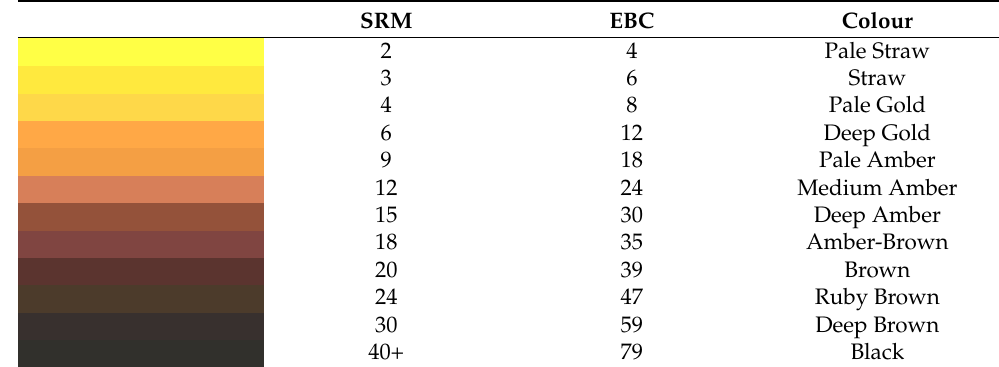
Table A1. Beer colour in SRM and EBC